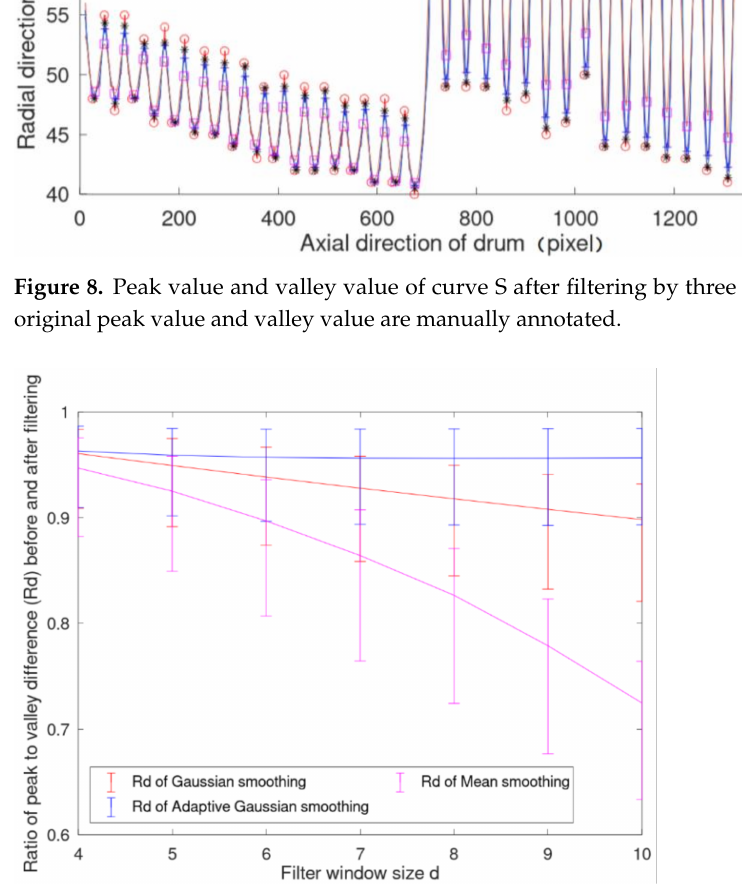
Figure 9. The retention of peak valley difference by the three filtering methods with different window sizes. The upper limit is the average retention rate of the peak valley difference at the projection of the wire rope, and the lower limit is the average retention rate of the peak valley difference at the projection of the rope